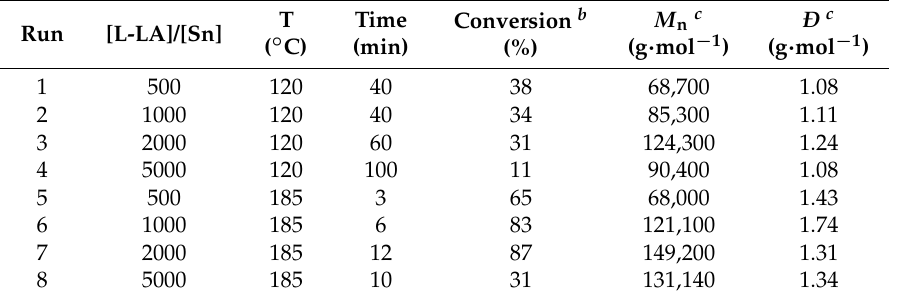
Table 1. Bulk polymerization of L -lactide ( L -LA) with Sn(Oct) 2 at the laboratory scale a .